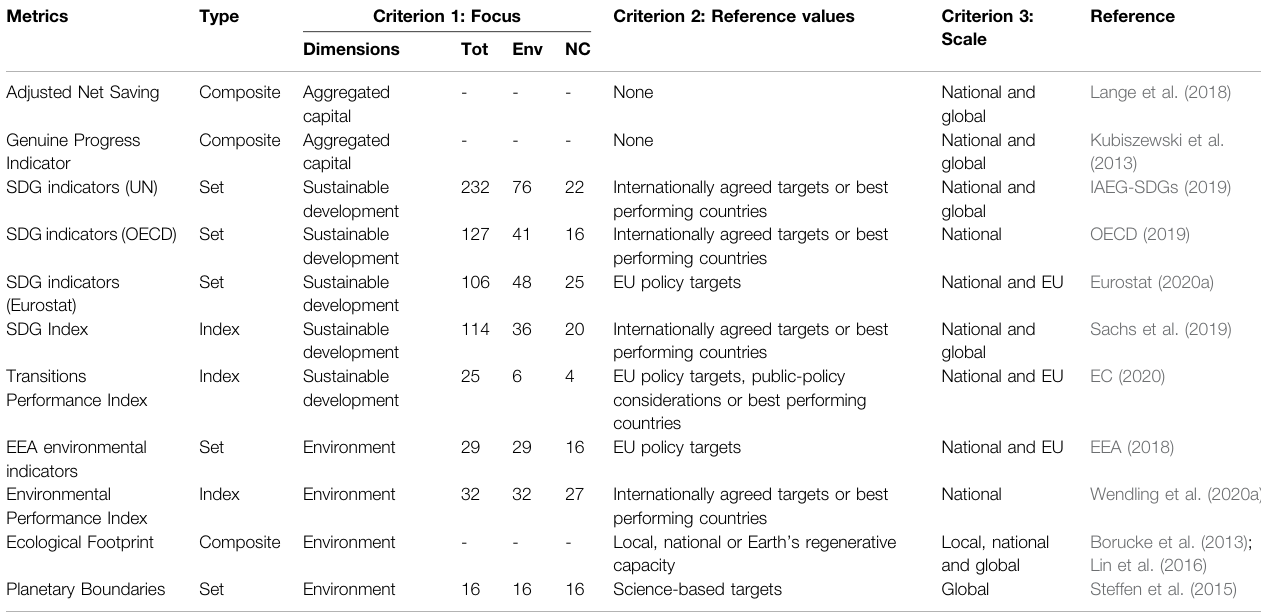
TABLE 2 | Assessment of metrics related to (environmental)